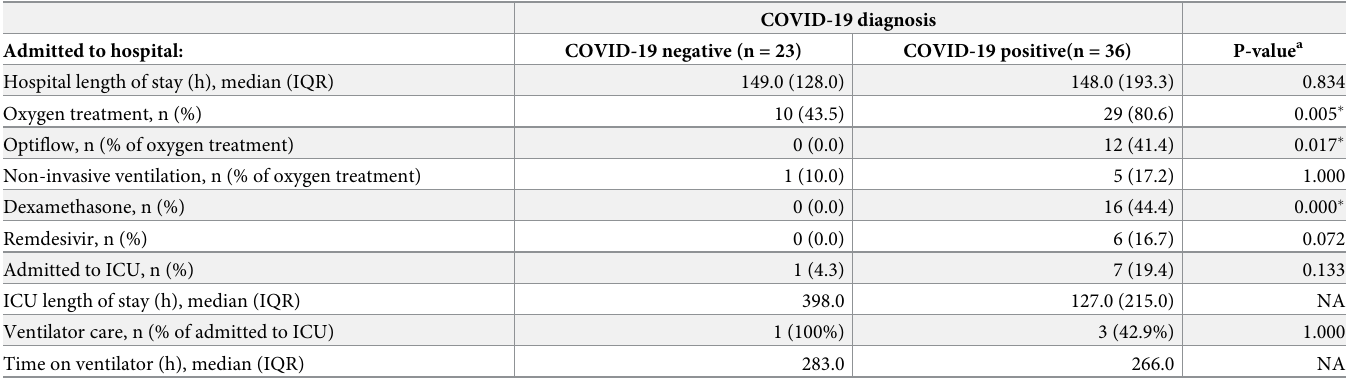
Table 2. Time and treatments in hospital.